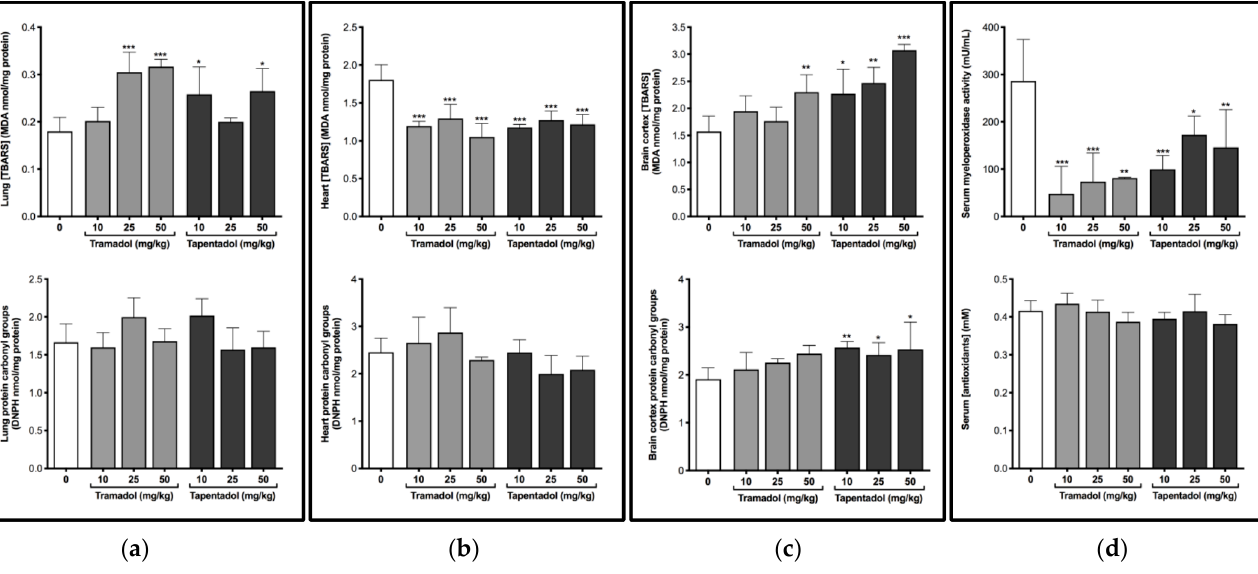
Figure 1. Oxidative stress analysis, assayed as thiobarbituric acid reactive substances (TBARS) and protein carbonyl groups, in Wistar rat lung ( a ), heart ( b ) and brain cortex ( c ) tissue homogenates, as well as serum myeloperoxidase (MPO) activity and total antioxidant capacity (Trolox equivalents) ( d ). Both tissue homogenates and serum samples were processed upon repeated daily intraperitoneal (i.p.) administration of 10, 25, or 50 mg/kg tramadol or tapentadol, for 14 consecutive days. TBARS and protein carbonyl group results were normalized against total protein content. Results are expressed by means ± SD. *** p < 0.001, ** p < 0.01, * p < 0.05. DNPH: 2,4-dinitrophenylhydrazine; MDA: malondialdehyde.